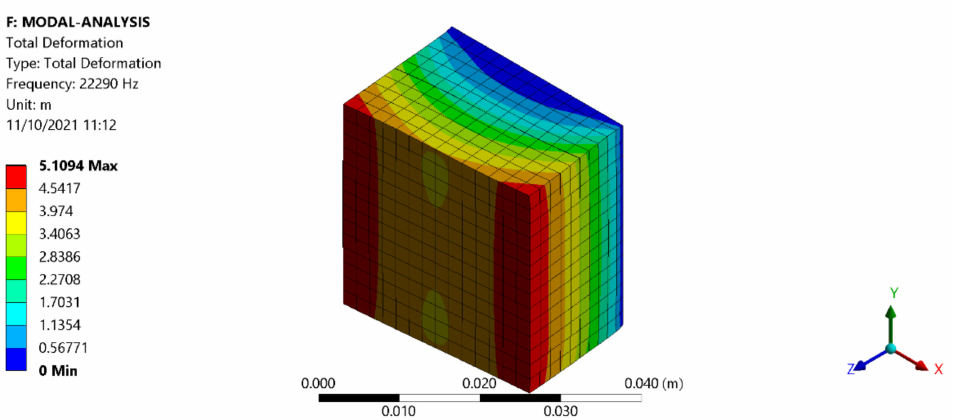
Figure 12. First modal shape of the